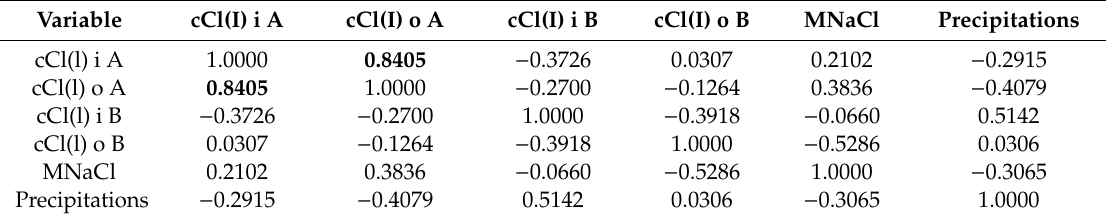
Table 11. Correlation matrix for the evaluation of chloride concentrations in watercourses at Sites A and B (Pearson correlation). Sample size n = 13.